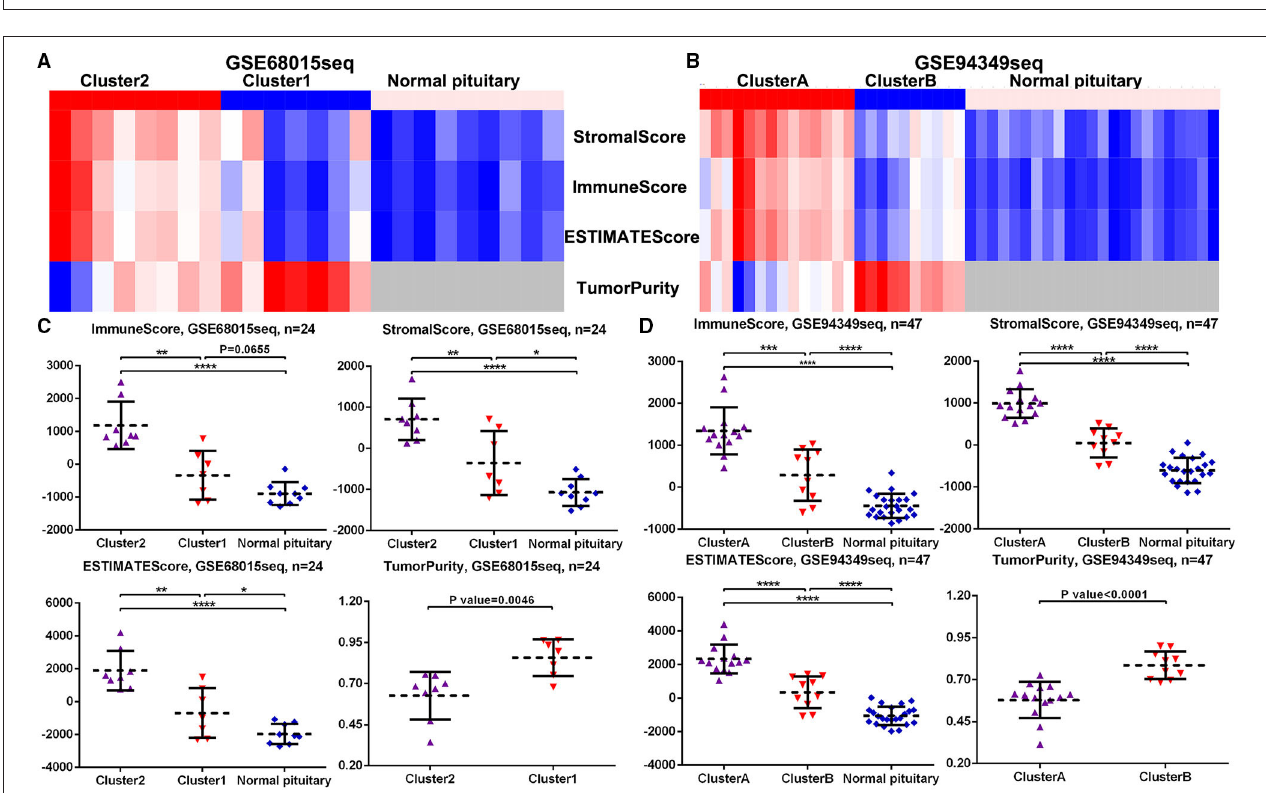
FIGURE 4 | Scores in the IG and IR subtypes of ACPs. (A,B) Heat map displaying the distribution of scores among cluster 1/2, cluster A/B and normal pituitary groups in the GSE68015 and GSE94349 databases. (C,D) The Scatter plot demonstrated the ratio differentiation of scores and TumorPurity among cluster 1/2, cluster A/B and normal pituitary groups in the GSE68015 and GSE94349 databases. * p < 0.05, ** p < 0.01, *** p < 0.001, **** p < 0.0001.